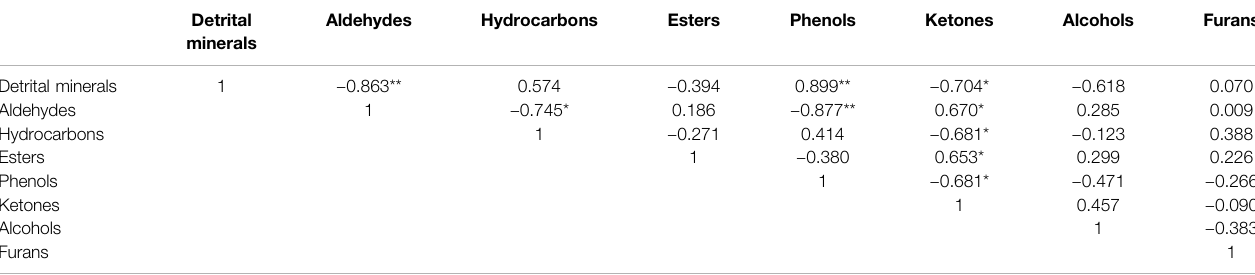
TABLE 4 | Correlation analysis between clastic rocks and organic matter. Detrital minerals